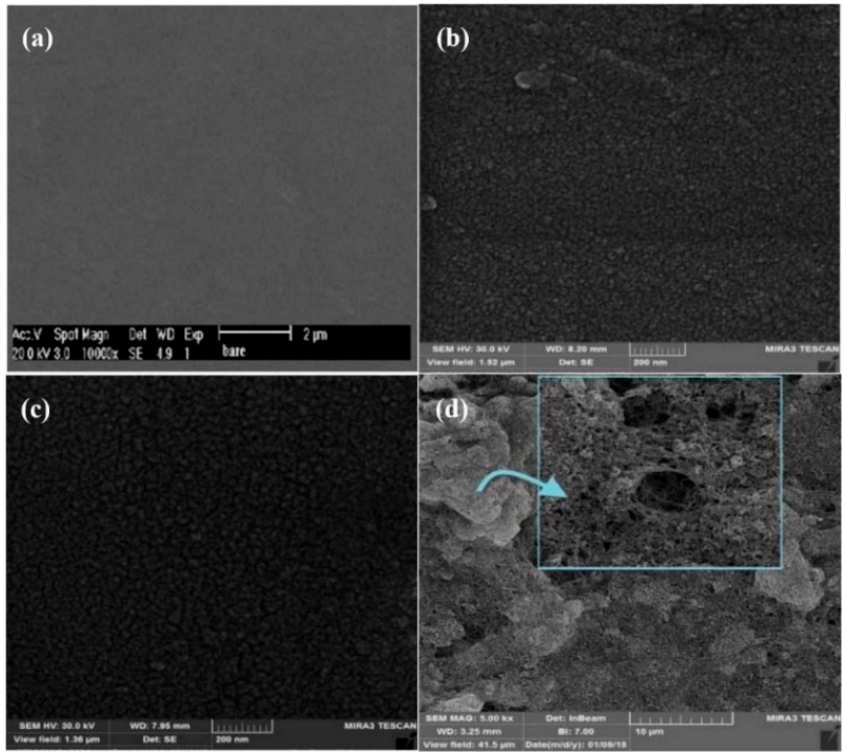
Figure 18. FESEM images of ( a ) bare standard GCE, ( b ) nanoporous GCE, ( c ) PCC/nanoporous GCE and ( d ) CS-MWCNTs+TiO 2 NPs/PCC/nanoporous GCE. Reproduced with permission from [214]. Copyright 2018 Electrochemical Society,